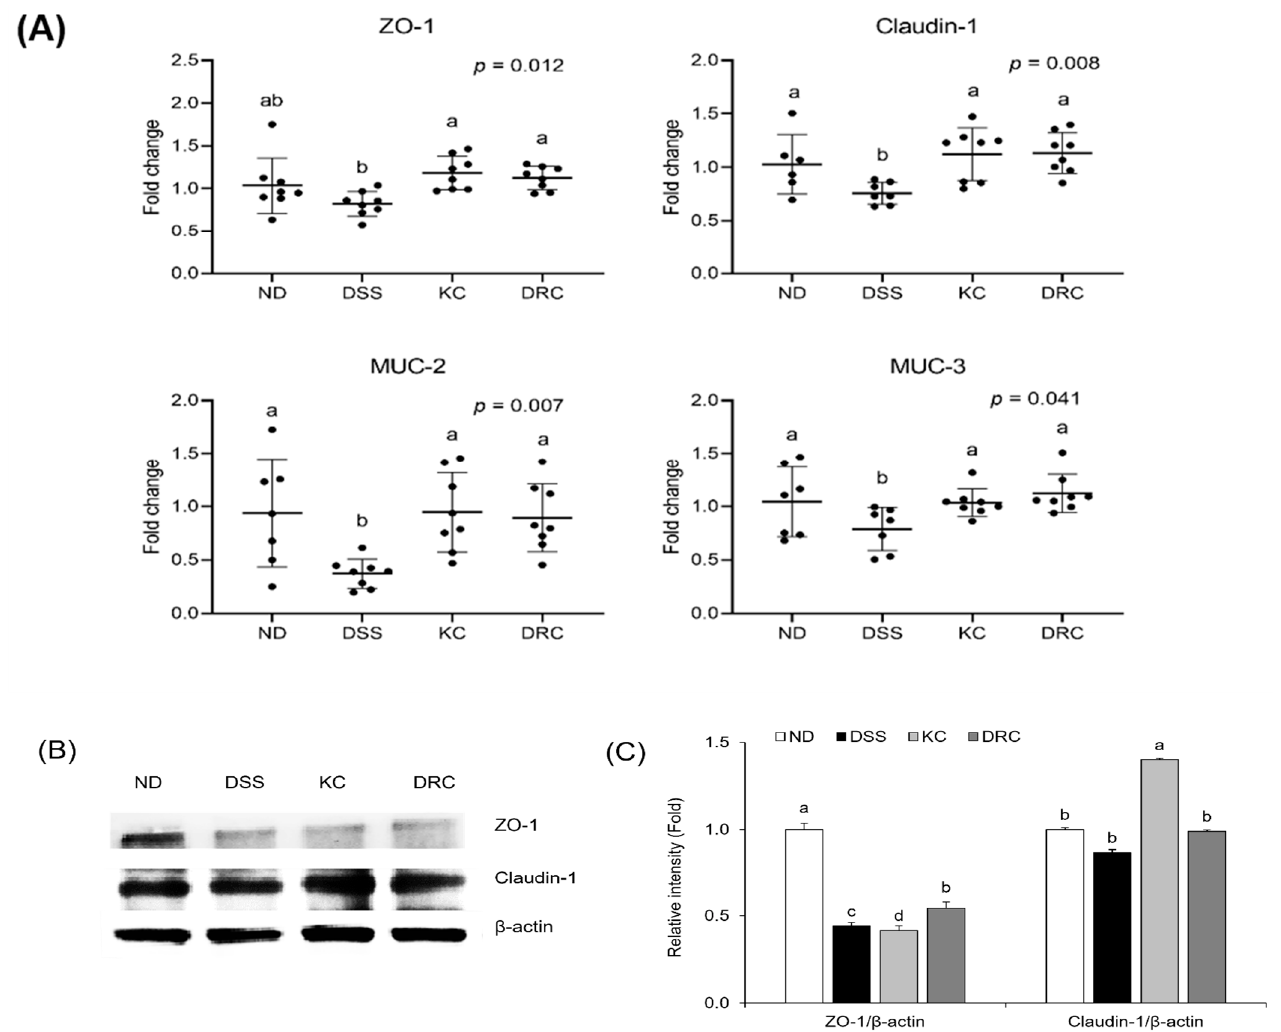
Figure 6. Effects of kimchi and Leu. mesenteroides DRC 1506 on the expression of mRNA ( A ) and protein ( B , C ) of tight junction protein and mucin. ( A ) The relative mRNA expression of the target genes was quantified and normalized by β -actin. The value was expressed as fold changes, with the ND group as the control. Data values are expressed as scatter plots with median, minimum, and maximum values ( n = 6–8 per group). Comparisons among groups were evaluated using one-way ANOVA with Duncan’s post hoc test. Groups with different letters had a significant difference at p < 0.05. ( B ) Representative image by Western blot. ( C ) The relative expression level of protein was quantified by Image J. The relative expression levels of protein were quantified and normalized by β -actin. The value was expressed as fold changes with the ND group as the control. Values were presented as bar graphs with means ± SD ( n = 6 per group). Comparisons among groups were analyzed by one-way ANOVA with Duncan’s post hoc test. Groups with different letters had a significant difference at p < 0.05. The presented data were from one representative experiment out of three. ND, normal group; DSS, DSS-treated group; KC, DSS + 1 × 10 9 CFU/day/mouse of kimchi group; DRC, DSS + 1 × 10 9 CFU/day/mouse of Leu. mesenteroides DRC 1506 isolated from